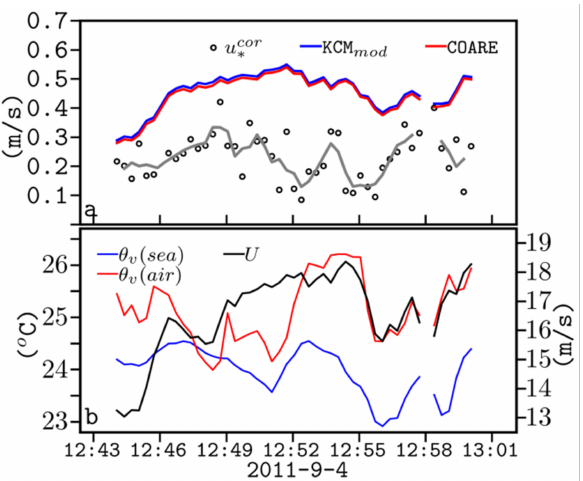
Figure 8. ( a ) Time-series (UTC time) of observed height-corrected friction velocity u cor ∗ (black circles) and smoothed (grey line). Estimated surface friction velocity u ∗ , by KCM mod (blue line) and COARE (red line). ( b ) Time-series of observed meteorological variables, potential virtual temperature of sea surface θ v ( sea ) (blue line), and air θ v ( air ) (red line) and wind speed U (black line). The flight segment is at the east-central AS, on 7 September 2011 (as displayed in Figure 2a).